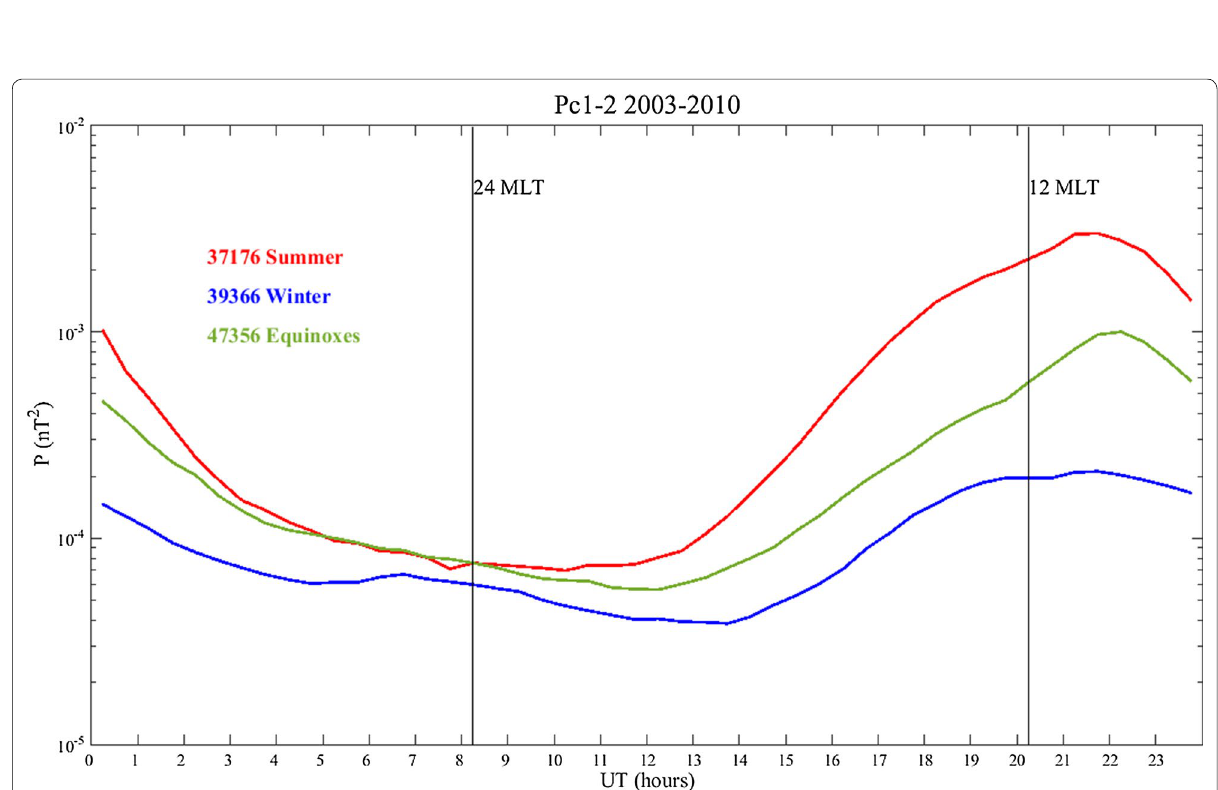
Fig. 2 Interplanetary and geomagnetic conditions in the time interval August 15, 2007–January 1, 2008. 30-min averages of SW density and speed and 30-min averages of AE index and total power